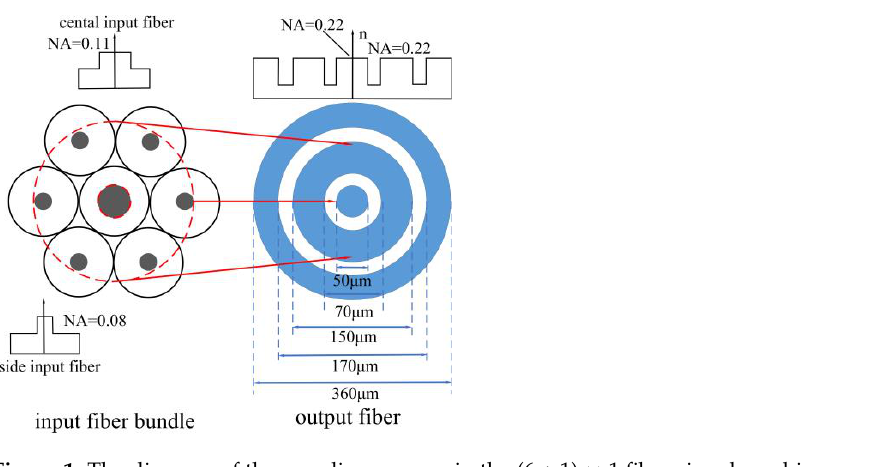
Figure 1. The diagram of the coupling process in the (6 + 1) × 1 fiber signal combiner.